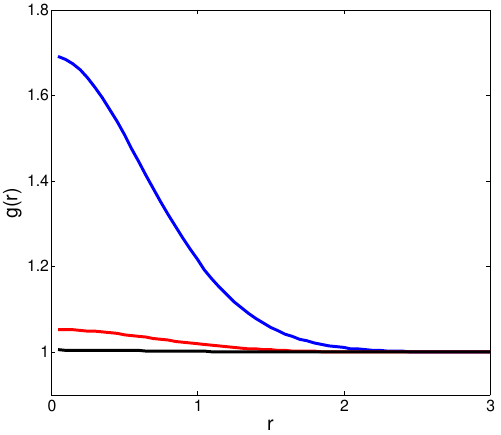
Figure 2 . The radial distribution functions g ( r ) of the Schwarzschild-AdS black holes at P = 0 . 001 and various temperatures. The values of the temperatures from top to bottom are set as T = 0 . 1 , T = 1 and T = 10 . The large Schwarzschild-AdS black holes are globally stable at these temperatures and